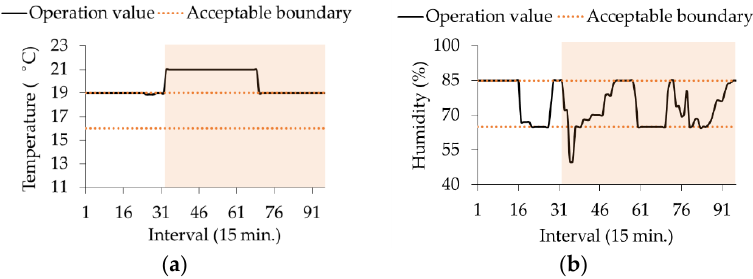
Figure 10. Environmental control of a building microgrid with rooftop greenhouse: ( a ) Temperature; ( b ) Humidity.